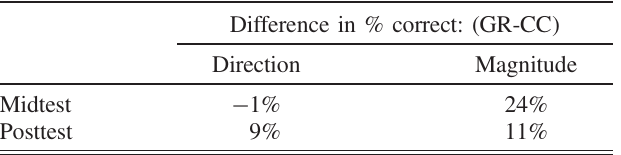
TABLE II. The difference by condition (GR — CC) of percent- age of correct responses on the midtest and posttest questions. Difference in % correct: